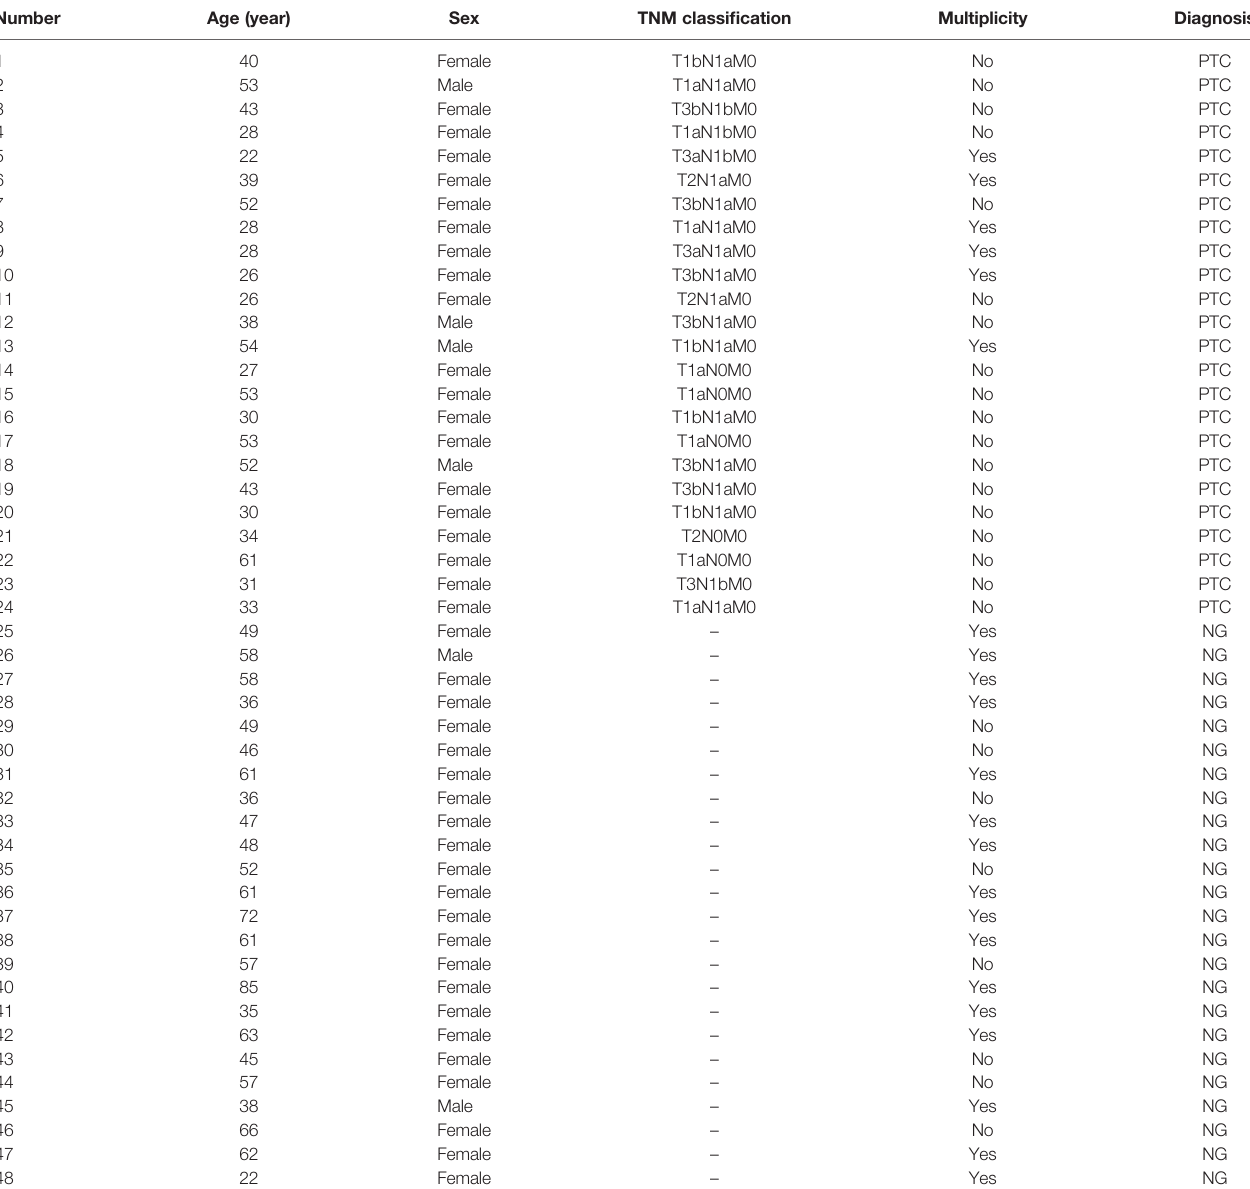
TABLE 2 | Detailed information of characteristics of study samples used in ELISA.